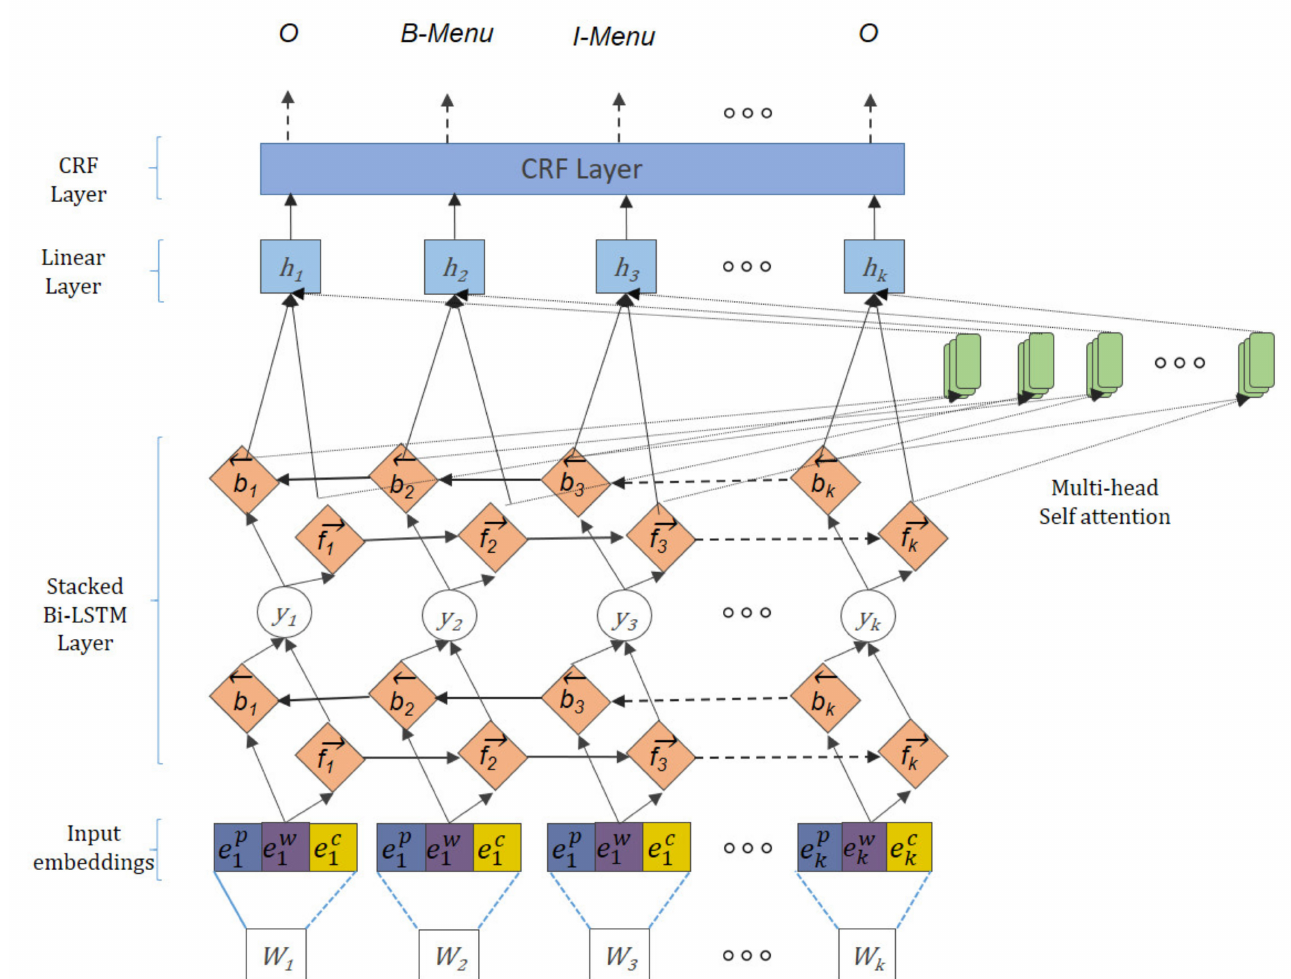
Figure 4. The proposed Bi-LSTM-CRF neural network with a variation of multi-head self-attention for MenuNER task, fine-tuned on domain specific